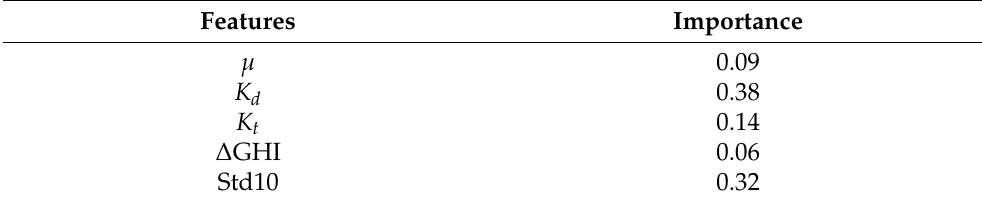
Table 2. The importance of inputs for the RF CSD